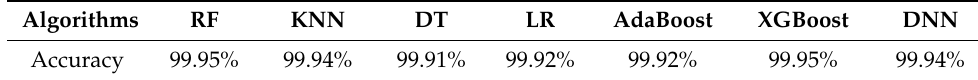
Table 6. Accuracies of the ML models on imbalanced dataset.